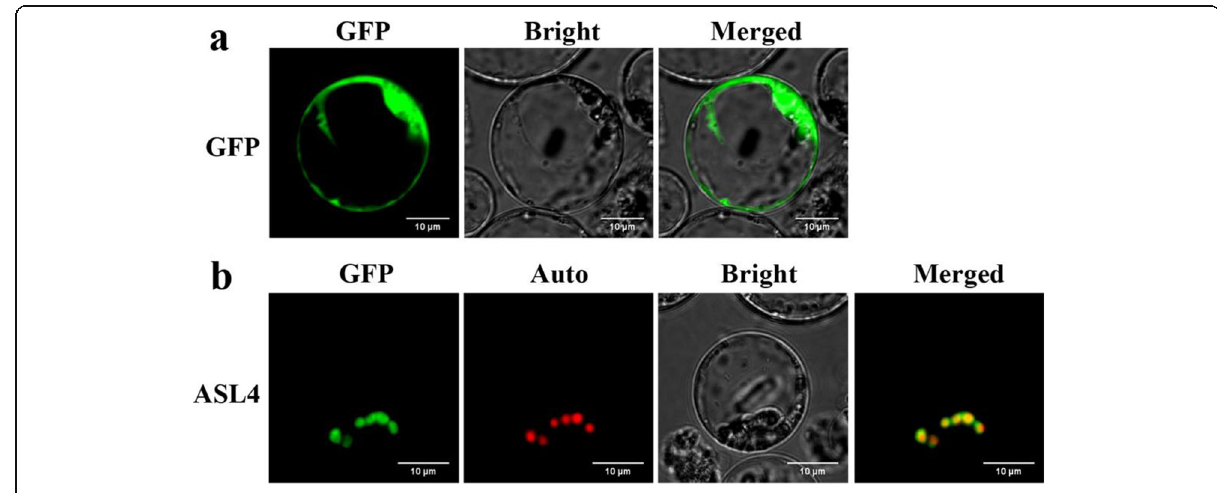
Fig. 4 Subcellular location of ASL4 protein. a Free GFP signals in rice protoplasts. b ASL4-GFP signals were co-localized with chlorophyll autofluorescence in rice protoplasts. GFP, GFP signals of free GFP and ASL4; Auto, chlorophyll autofluorescence; Bright, bright field; Merged, merged images